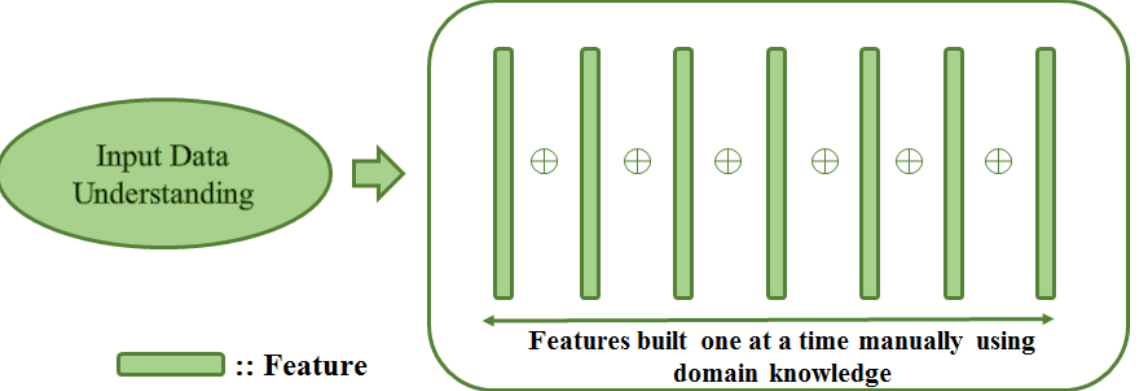
Figure 6. Manual feature engineering process: Features are crafted one at a time using domain knowledge by understanding underlying